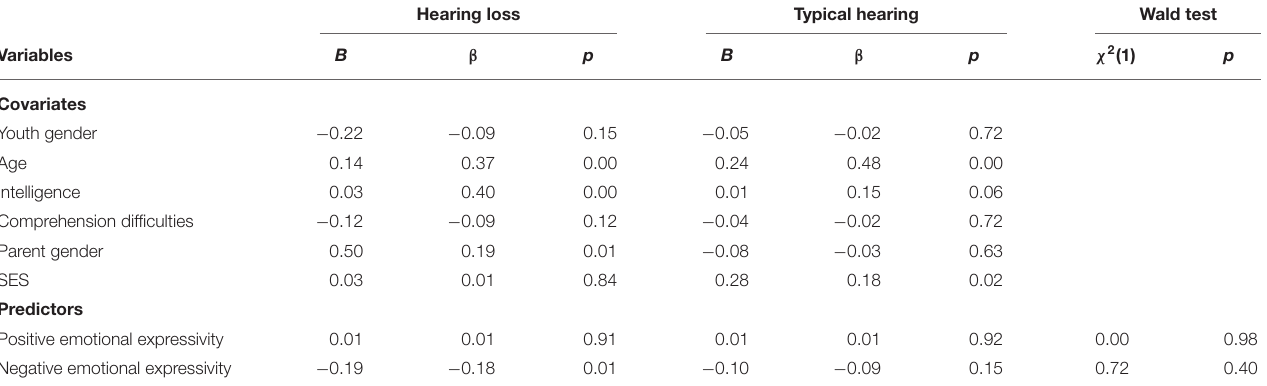
TABLE 3 | Multigroup regressions of parental emotional expressivity on emotion